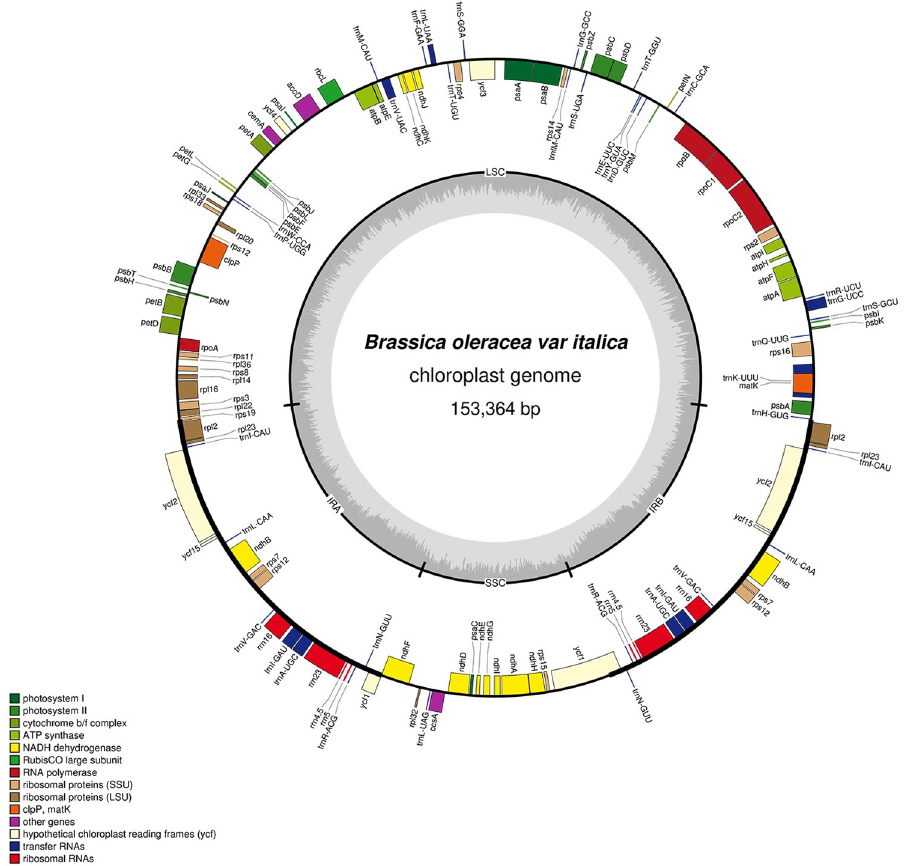
Fig 1. Physical map of the B . oleracea var. italica cp